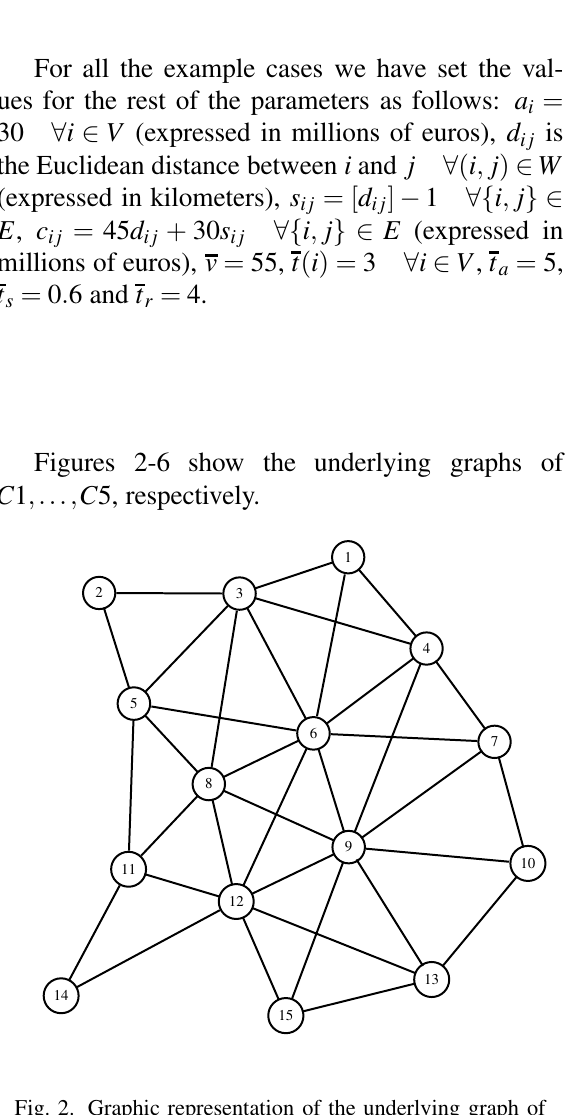
Fig. 2. Graphic representation of the underlying graph of